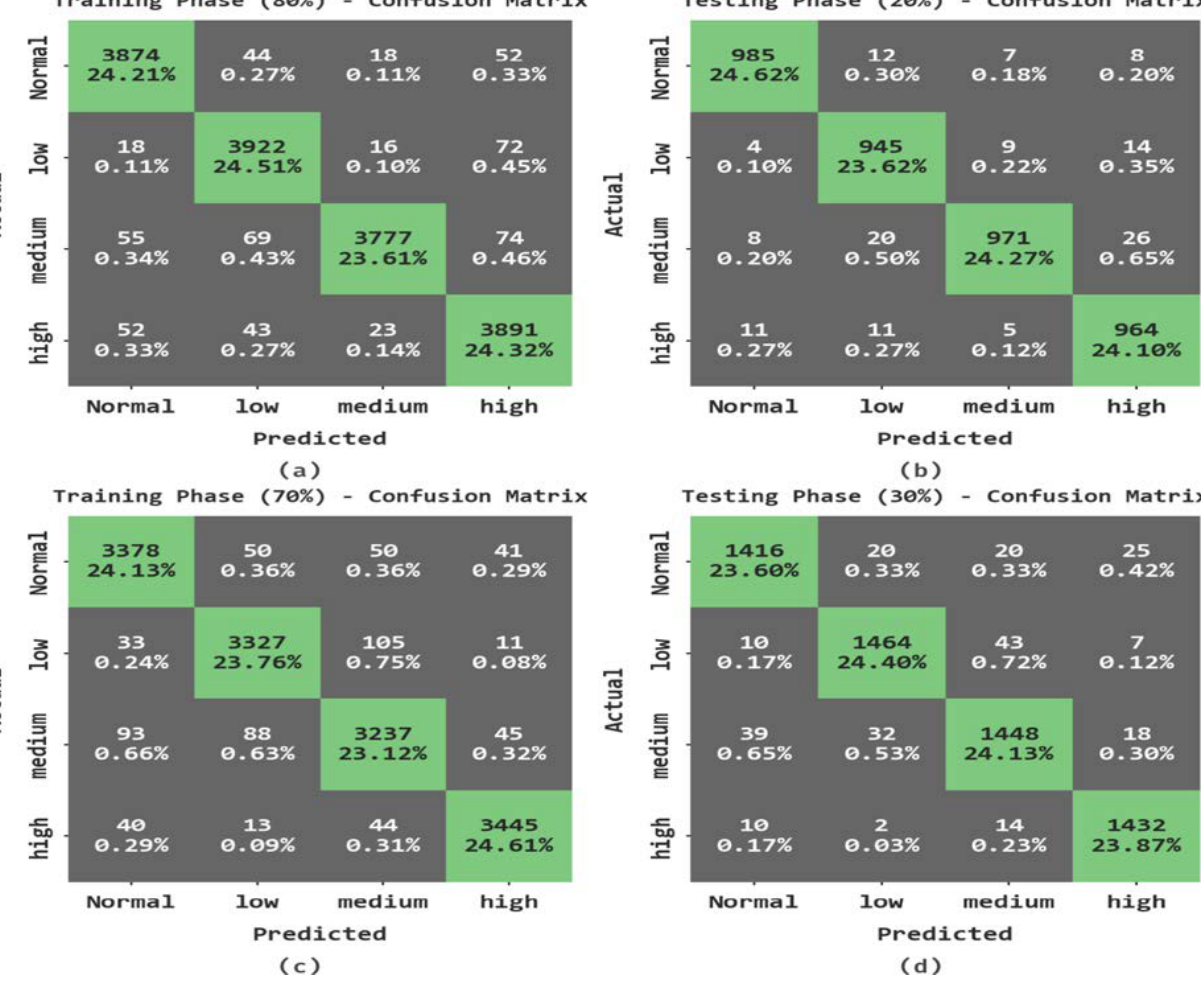
Figure 7. Confusion matrices of the PPIE-ODLASC approach; ( a , b ) TR and TS databases of 80:20 and ( c , d ) TR and TS databases of 70:30. Table 5. Accident severity classification outcome of the PPIE-ODLASC approach with varying measures.